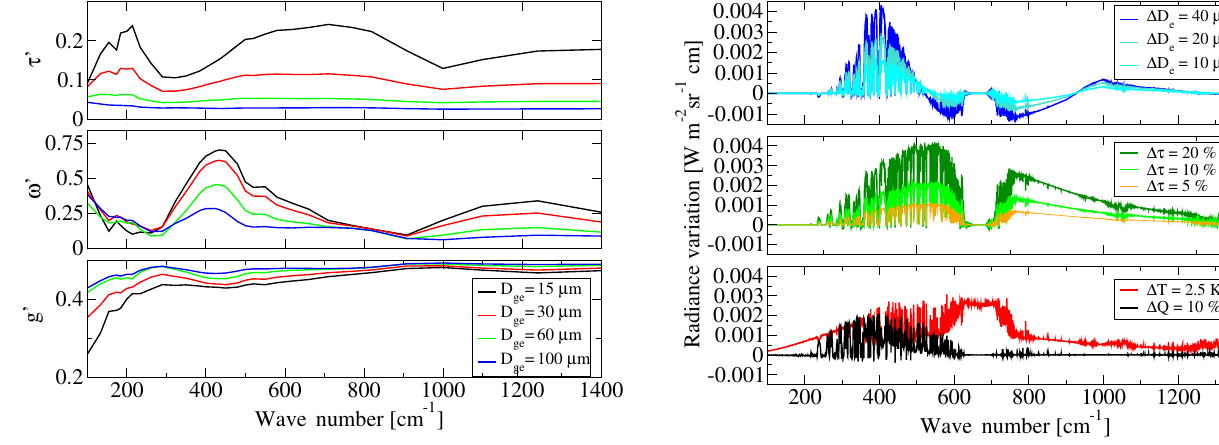
Figure 1. Scaled optical parameters for different values of D ge . The optical depth τ is calculated for IWP = 2gm − 2 .